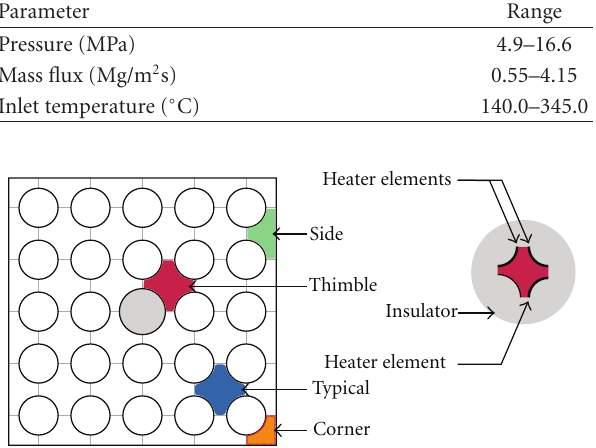
Figure 1: Isolated subchannel geometry types (left) and cross- section of the central type test section (right)